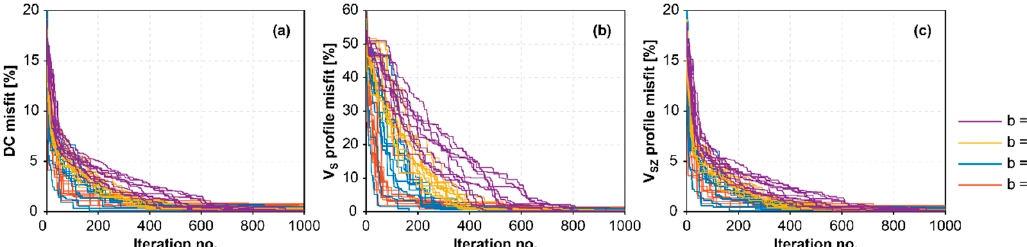
Figure 6. Inversion of the unperturbed synthetic dispersion curve from model A. A two-layer geologic structure was assumed with the initial position of the layer interface at a depth of 10 m. ( a ) Data fitting progression in terms of DC misfit. Model fitting progression defined in terms of ( b ) V S -profile misfit and ( c ) V SZ -profile misfit. Ten curves are shown for each b -value as the Monte Carlo simulation is based on 10 × 1000 iterations.